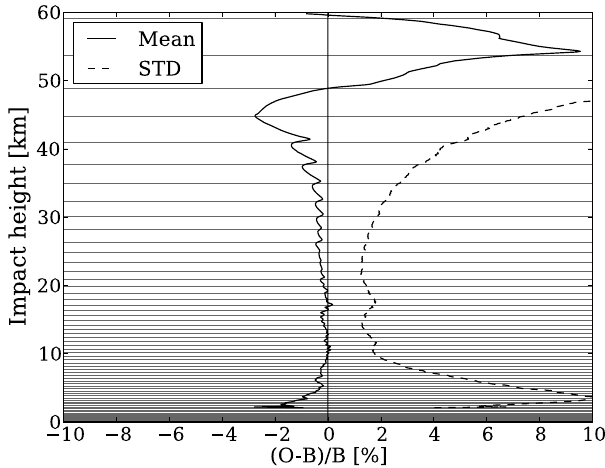
Figure 2. Refractivity innovations from 25 Met Office (6-hourly) model cycles, with observation data from all available RO instru- ments. The period started with the 00Z analysis on 1 January 2014. The refractivity between model levels is calculated using Eq. (2). Typical heights of the model levels are overlaid as horizontal lines.